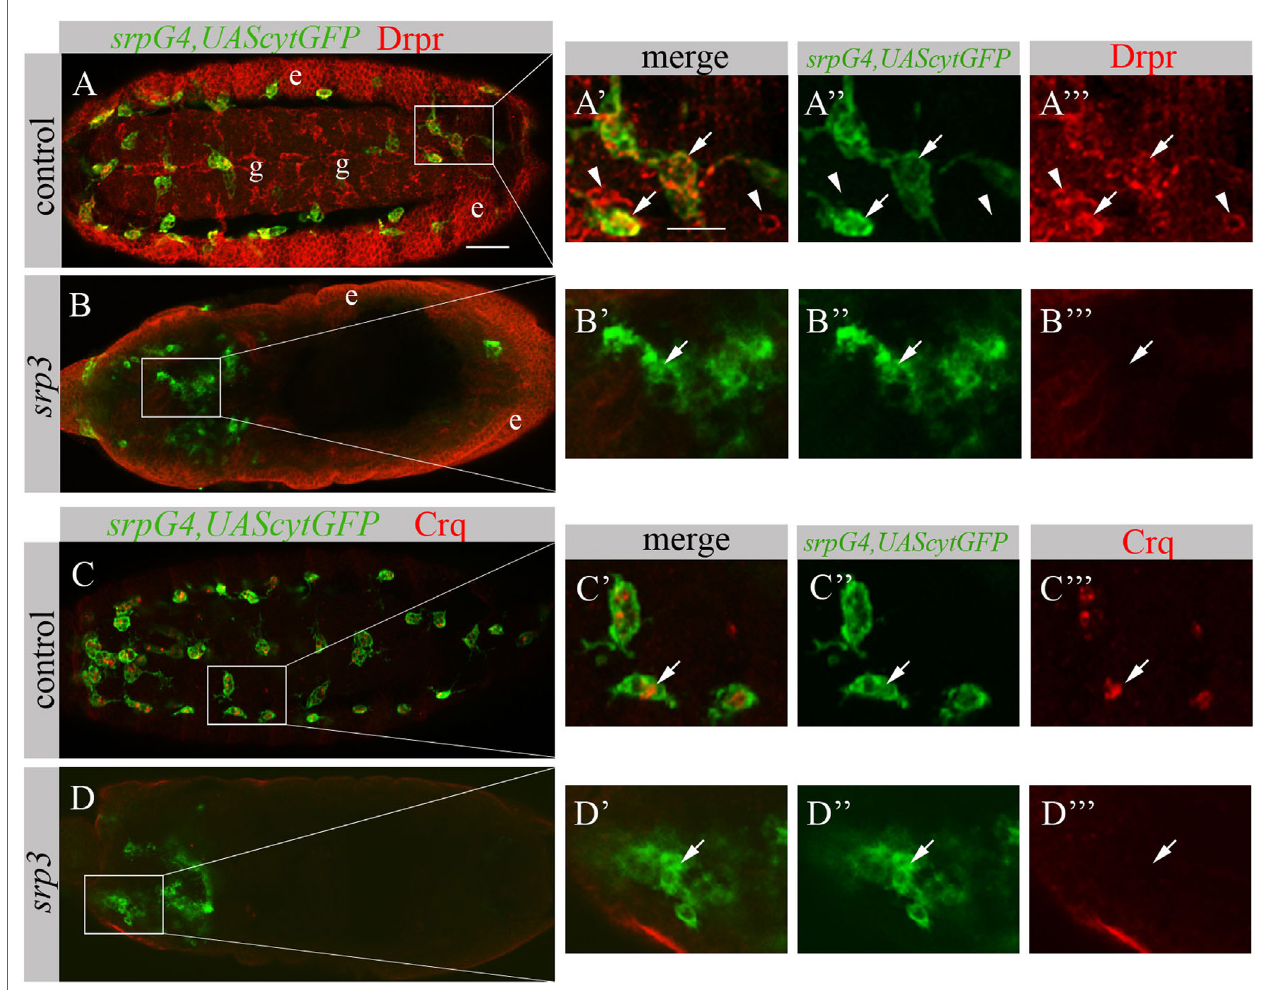
FigUre 5 | Srp is required for Drpr and Crq expression in embryonic macrophages. (a–D’’’) Projections from confocal stacks of the stage 16 embryos, ventral (a–a’’’) or dorsal view (B–D’’’) . Macrophages are labeled with srpGal4,UAScytGFP (green). (a–B’’’) Anti-Drpr in red, ectoderm (e) and glia (g). (c–D’’’) Anti-Crq in red. (a’–a’’’, B’–B’’’, c’–c’’’, D’–D’’’) Close up of rectangle areas in A,B,C and D respectively. (a–a’’’) Control srpGal4,UAScytGFP embryo expressing Drpr in GFP-positive macrophages (arrows) and GFP-negative glia (arrowheads). (c–c’’’) Control srpGal4,UAScytGFP embryo expressing Crq in GFP-positive macrophages (arrows). (B–B’’’, D–D’’’) srp 3 mutant embryos show no detectible Drpr (B, B’’’) and Crq (D,D’’’) staining in GFP-positive cells (arrows). Bar, 20